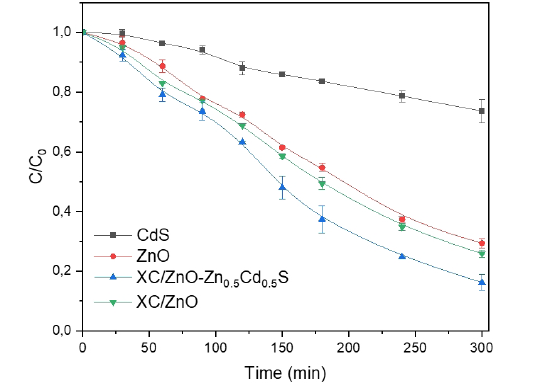
Figure 8. Solar light photocatalytic tests for the